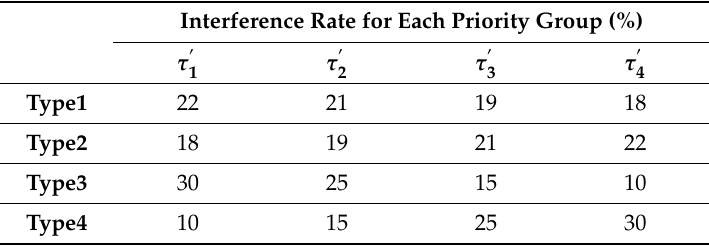
Table 2. UEP parameter settings for the average of the interference ratio, τ (cid:48) =